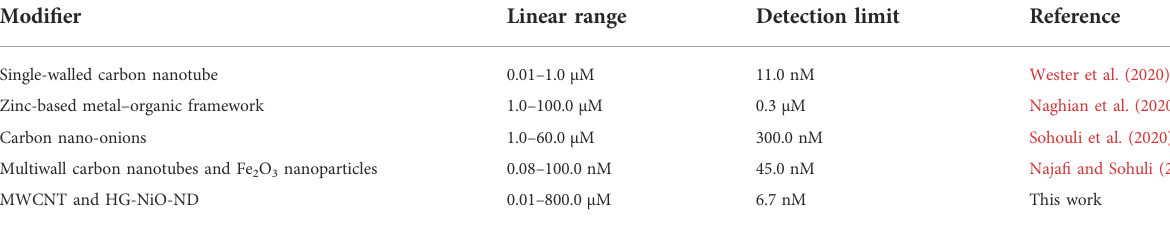
TABLE 2 Performance comparison of MWCNT/HG-NiO-ND/PGE for the determination of fentanyl with other electroanalytical methods. Modi fi